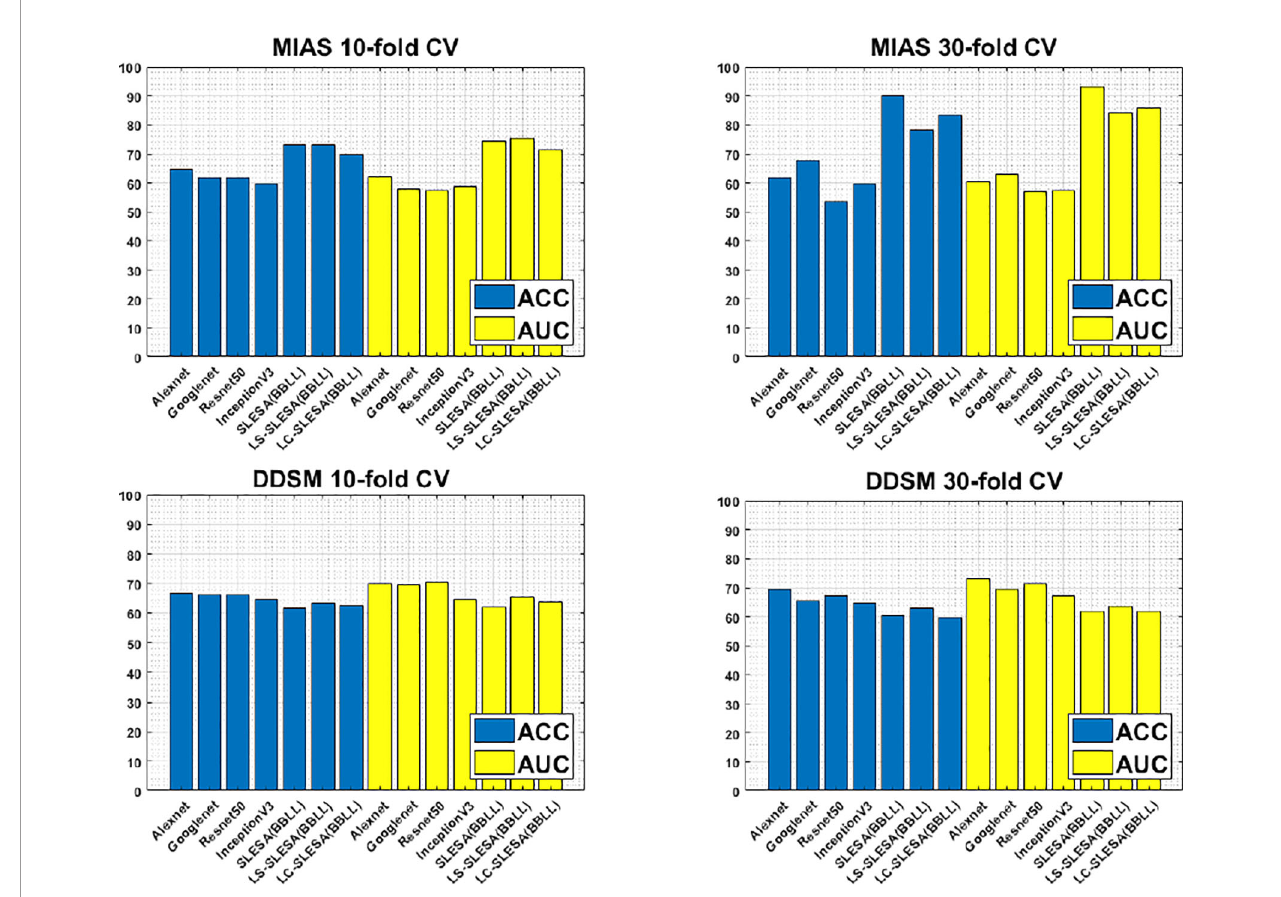
FIGURE 3 | ACC performance comparisons on MIAS (top row) and DDSM (bottom row) datasets using 10- and 30-fold cross-validation.